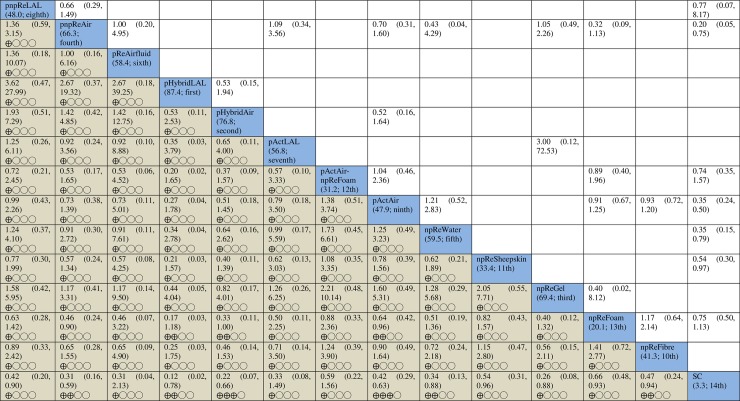
Results of pairwise meta-analyses via RevMan and network meta-analysis with consistency model via STATA for pressure ulcer incidence.Results of pairwise meta-analyses with the numbers of included studies and participants are presented above the diagonal cells (see S7 File); network meta-analysis results and the corresponding certainty of evidence assessments are shown below the diagonal cells. The diagonal cells show the codes of intervention groups and their SUCRA values and rankings in brackets: SC = standard hospital surfaces, npReFibre = non-powered reactive fibre surfaces, npReFoam = non-powered reactive foam surfaces, npReGel = non-powered reactive gel surfaces, npReSheepskin = non-powered reactive sheepskin surfaces, npReWater = non-powered reactive water surfaces, pActAir = powered active air-cells surfaces, pActAirnpReFoam = powered active air-cells surfaces plus non-powered reactive foam surfaces, pActLAL = powered active low-air-loss air surfaces, pHybridAir = powered hybrid air-cells surfaces, pHybridLAL = powered hybrid low-air-loss air surfaces, pReAirfluid = powered reactive air-fluidised surfaces, pnpReAir = powered or non-powered reactive air-cells surfaces, and pnpReLAL = powered or non-powered reactive low-air-loss air surfaces. ⨁⨁⨁◯ = Moderate certainty of evidence; ⨁⨁◯◯ = Low certainty of evidence; and ⨁◯◯◯ = Very low certainty of evidence.